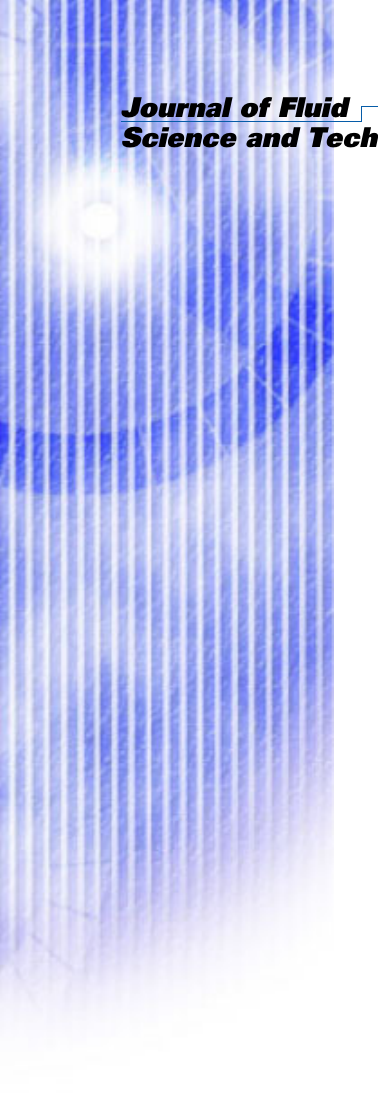
Fig. 4 Variation of ω c for di ff erent η , where π for the input (I), while (cid:7) and (cid:8) when φ = 0 and π for the input (II) and the broken line denotes the experimental